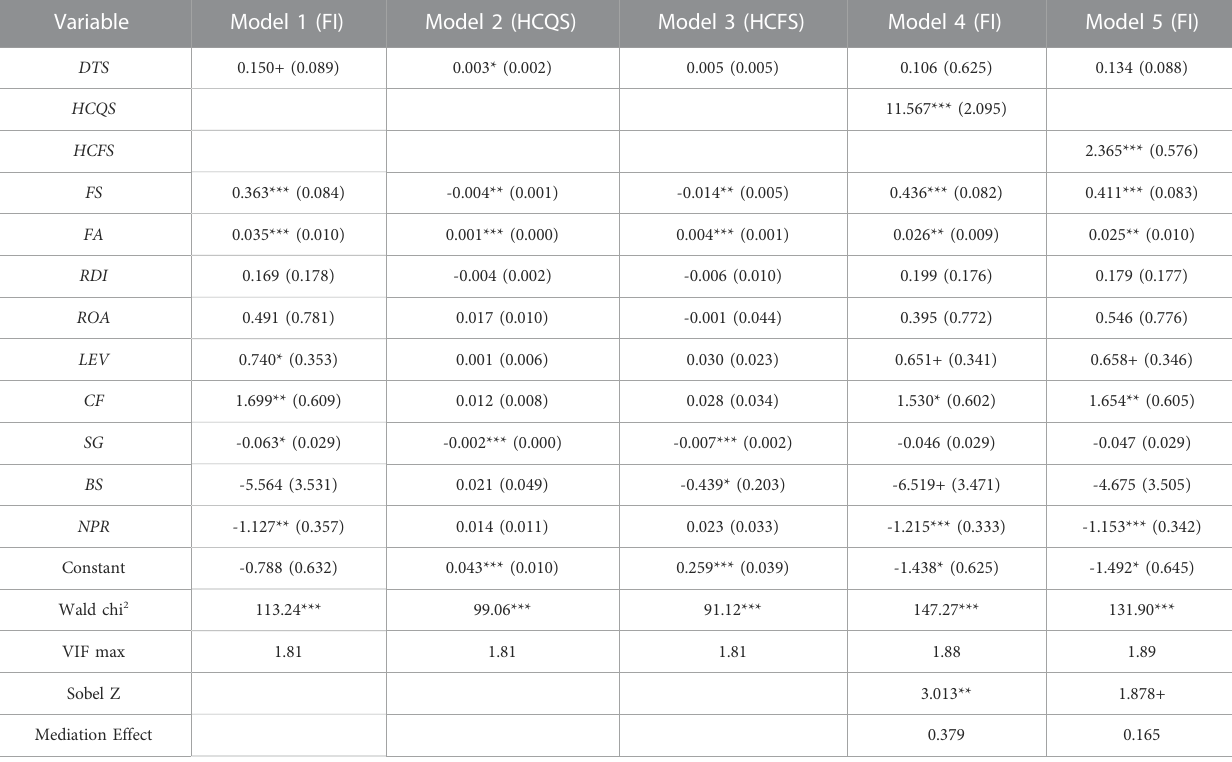
TABLE 8 Robust analysis-independent